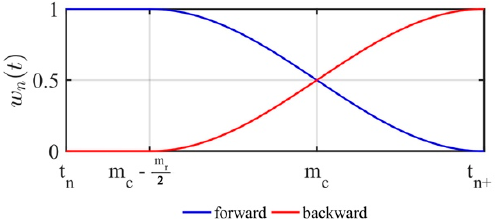
Figure 4. Example of the weighting function, w n ( t ) , for forward propagation (blue) and the function, 1 − w n ( t ) , for backwards propagation (red).